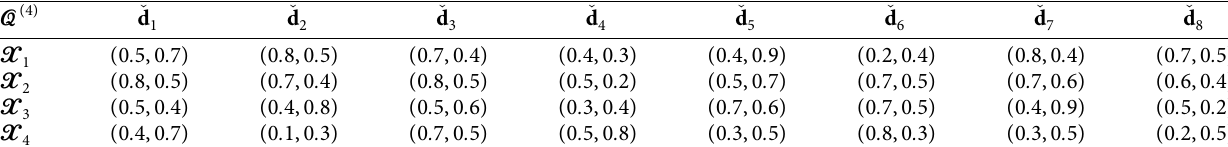
Table 4: Decision matrix for alternative Q ( 4 )